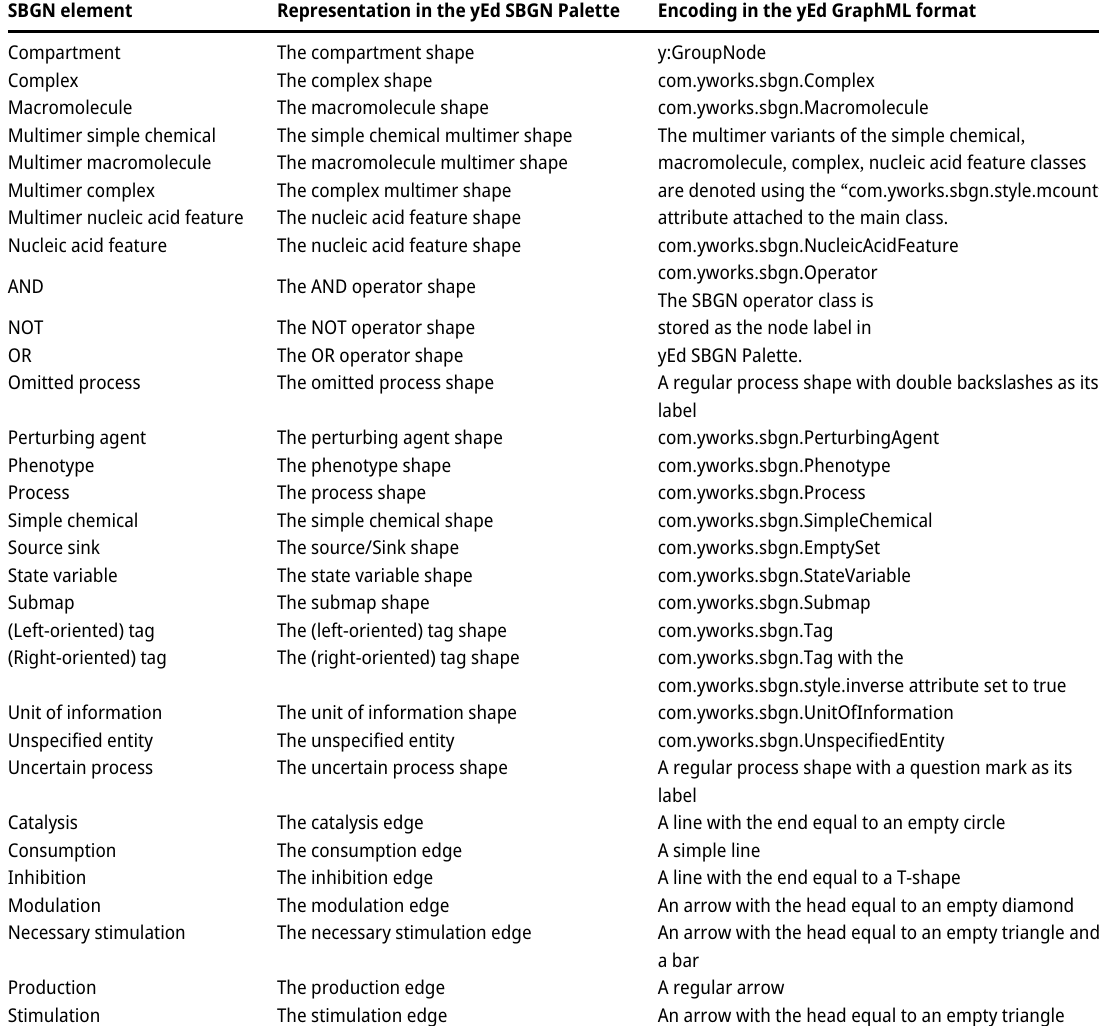
Table 1: SBGN PD elements and their representation in the yEd SBGN Paletteen. SBGN